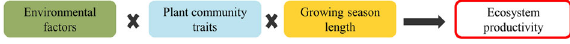
Fig. 1 An introduction to trait-based productivity (TBP) theory. As an analogy to the Production Ecology Equation, we use emergent thinking